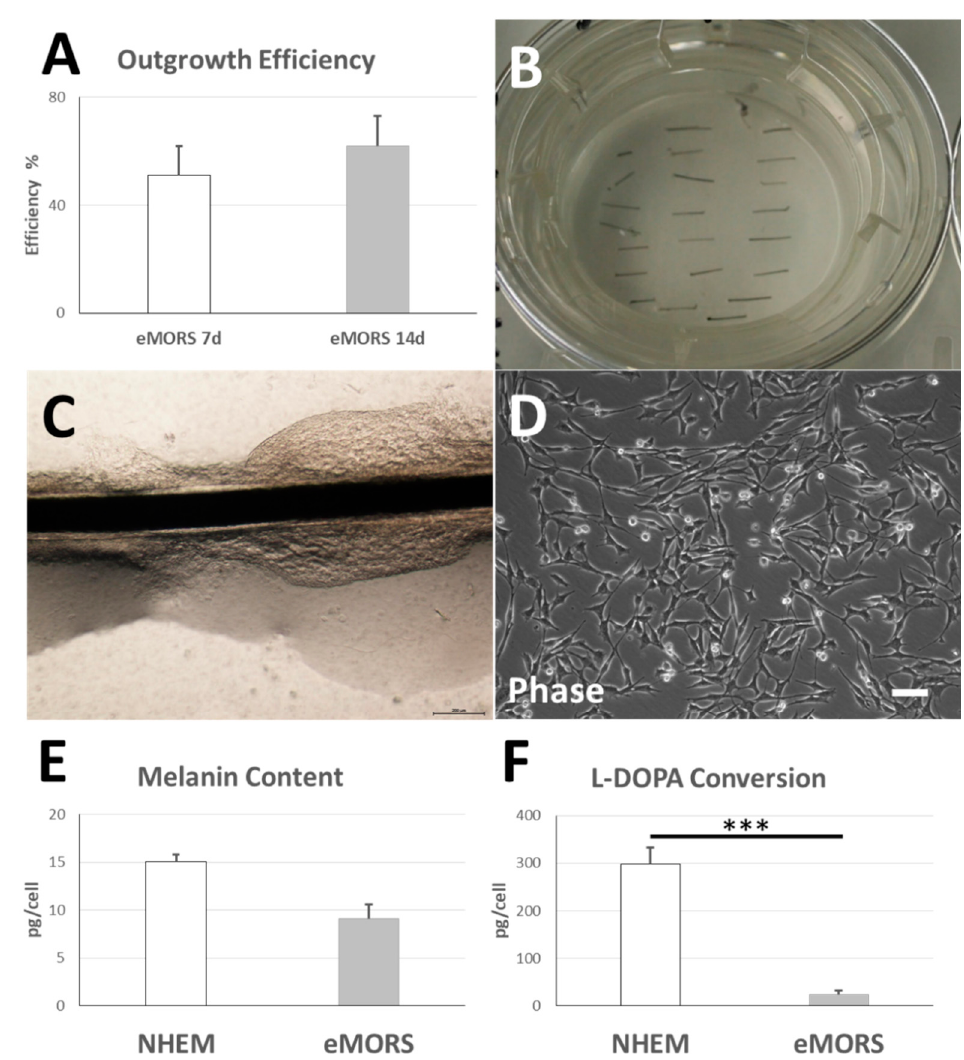
Figure 2. Isolation of horse hair follicles, migration of cells from the ORS and cell culture. Demonstration of isolating horse HM from the forelock hair follicle. The forehead skin tissue was excised from the equine forehead region, disinfected and intensively rinsed. The subcutaneous tissue was removed, and skin was chopped into long pieces. After collagenase digestion, the intact hair follicles were isolated from the loosened skin tissue. ( A ) Cell outgrowth efficiency of eMORS from the ORS. ( B ) Air-liquid interface culture on Transwell membrane. ( C ) ORS cells migrated out from the ORS onto the porous nylon membrane. ( D ) After being harvested from the membrane, horse HM adhered and proliferated on cell culture flasks in DLMS medium, displaying typical melanocyte morphology. ( E ) Melanin content of eMORS and L-DOPA conversion ( F ) compared with NHEM. Results were shown with mean ± SD, *** p < 0.001. Magnification ( D ): 10 × , scale bar: 200 µ